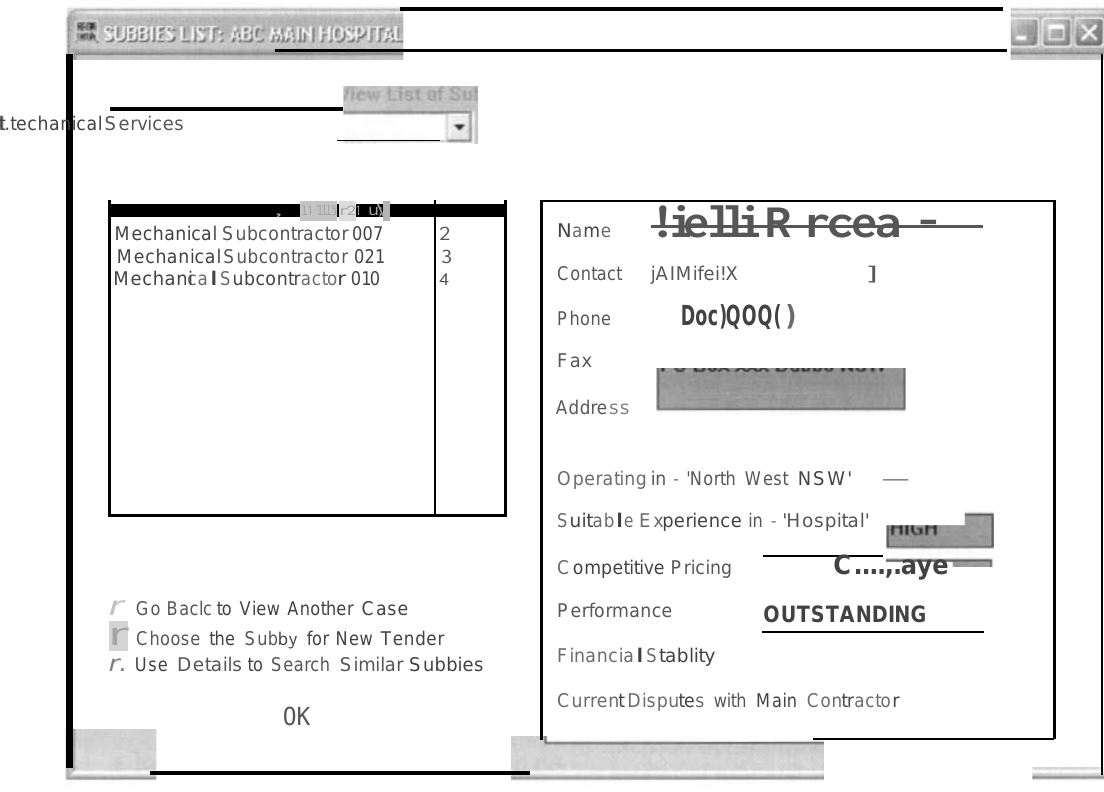
Figure 5: Subcontractor Details Screen in